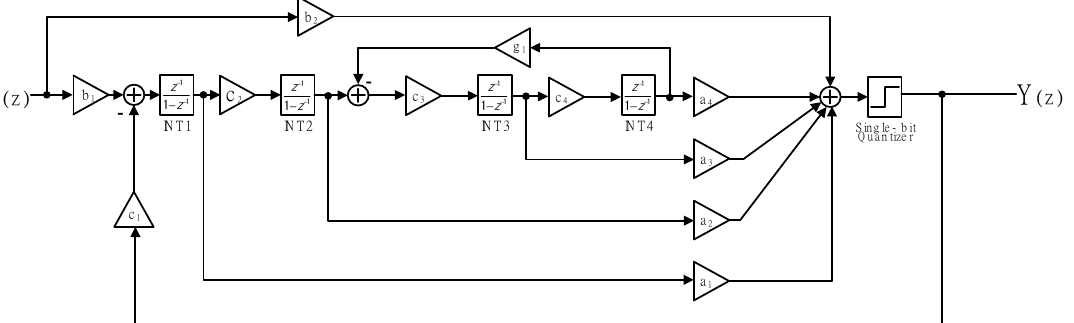
Figure 2. Fourth-order cascade-of-integrators with feedforward (CIFF) delta-sigma modulator (DSM) architecture.